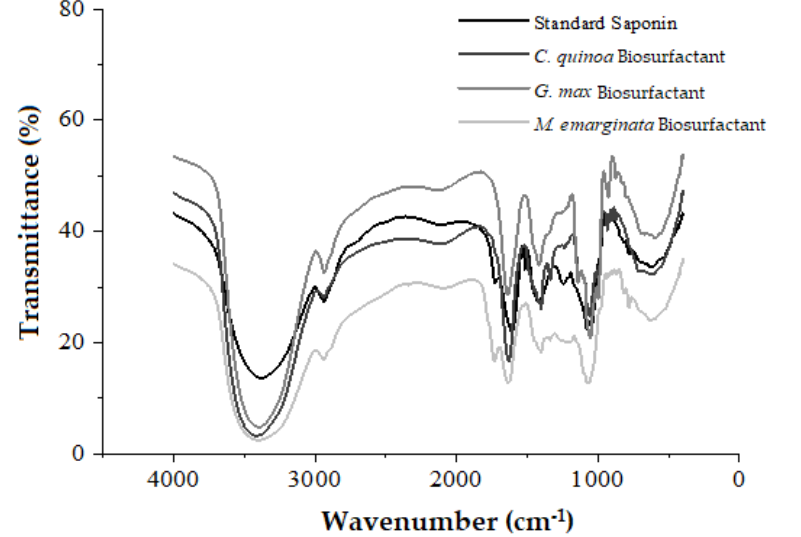
Figure 11. FTIR spectra of standard saponin (Sigma) and biosurfactants from Chenopodium quinoa , Glycine max , and Malpighia emarginata .